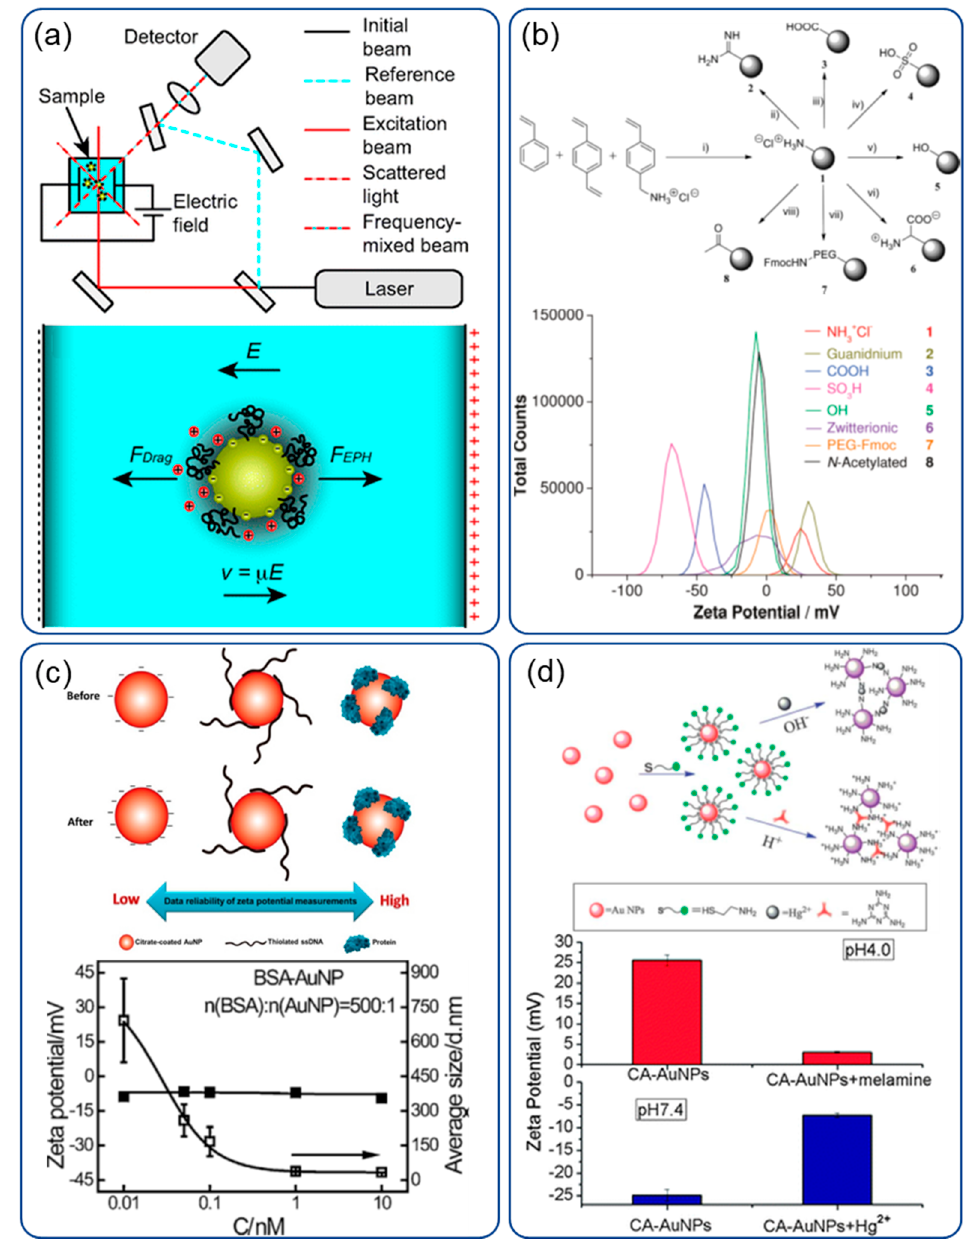
+ Hg 2 ions. Figure 6d outlines the sensing mechanism and the measured results. The decrease in negative charge on cysteamine-modified gold nanoparticles indicates the tendency of Hg 2 Sensors 2020 , 20 , x FOR PEER REVIEW